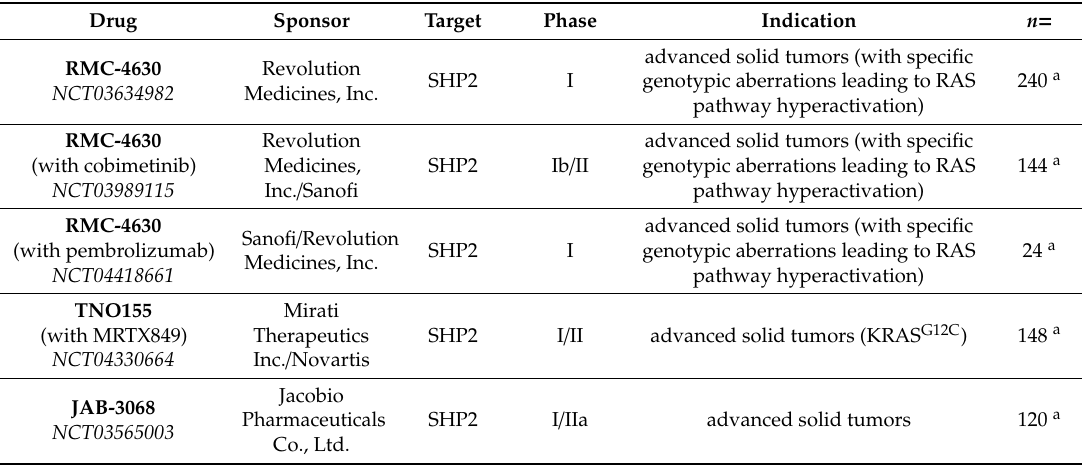
Table 2. Several compounds targeting the signaling cascade upstream of KRAS have reached clinical trials; however, only a few also include patients su ff ering from pancreatic ductal adenocarcinoma. Here, we focus on the inhibition of